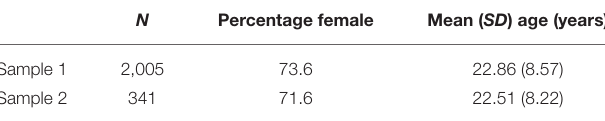
TABLE 3 | Exploratory factor analysis of the MEOS-VSF.